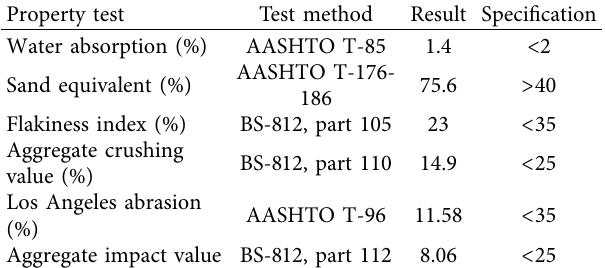
Table 2: Basic properties of aggregate.